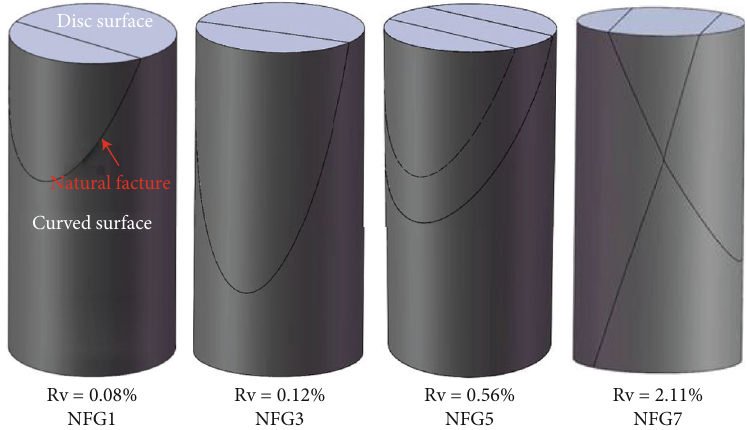
Figure 2: Scheme of natural fractures on granite samples used in the multistage fatigue loading test, the natural fractures are schemed in black color on the curved surfaces and disc